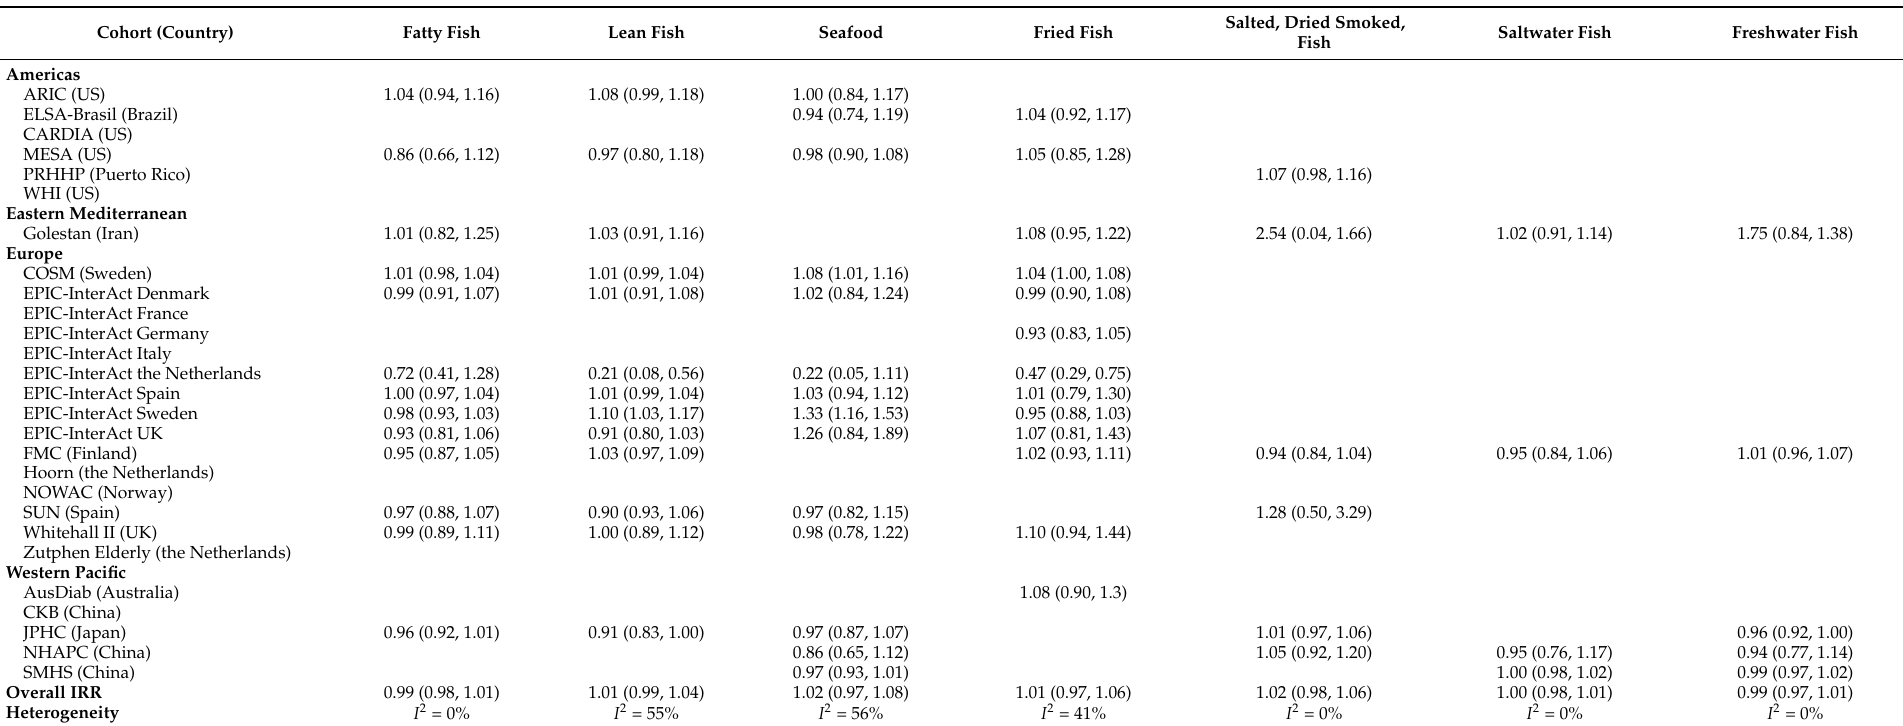
Table 3. Adjusted incidence rate ratios and 95% confidence intervals for the association between the consumption of different types of fish (per 100 g/week) and incident type 2 diabetes (primary outcome) in men in the InterConnect